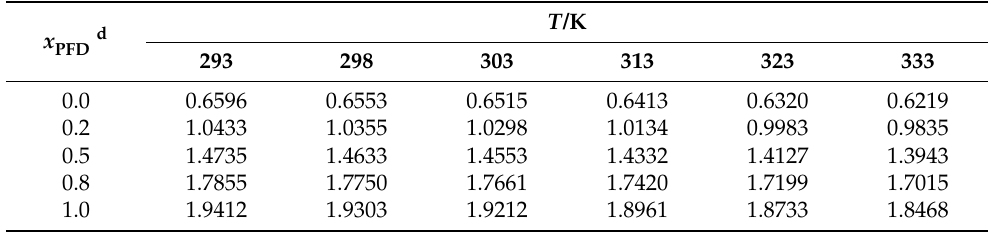
Table 1. As expected, with increase in temperature, the densities of PFD, n -hexane, and their mixtures were found to decrease primarily due to thermal expansion and follow a linear dependence according to the equation: